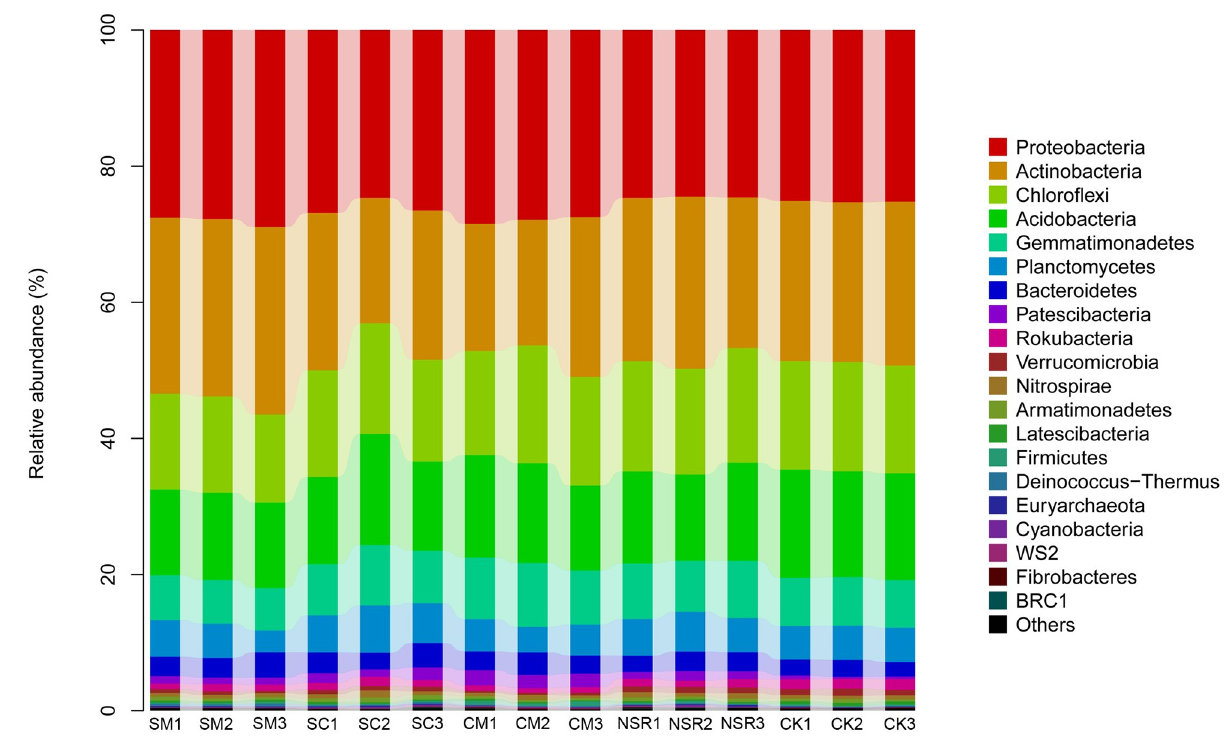
Fig 3. Taxonomic composition and abundance distribution of bacteria at the phylum level under different